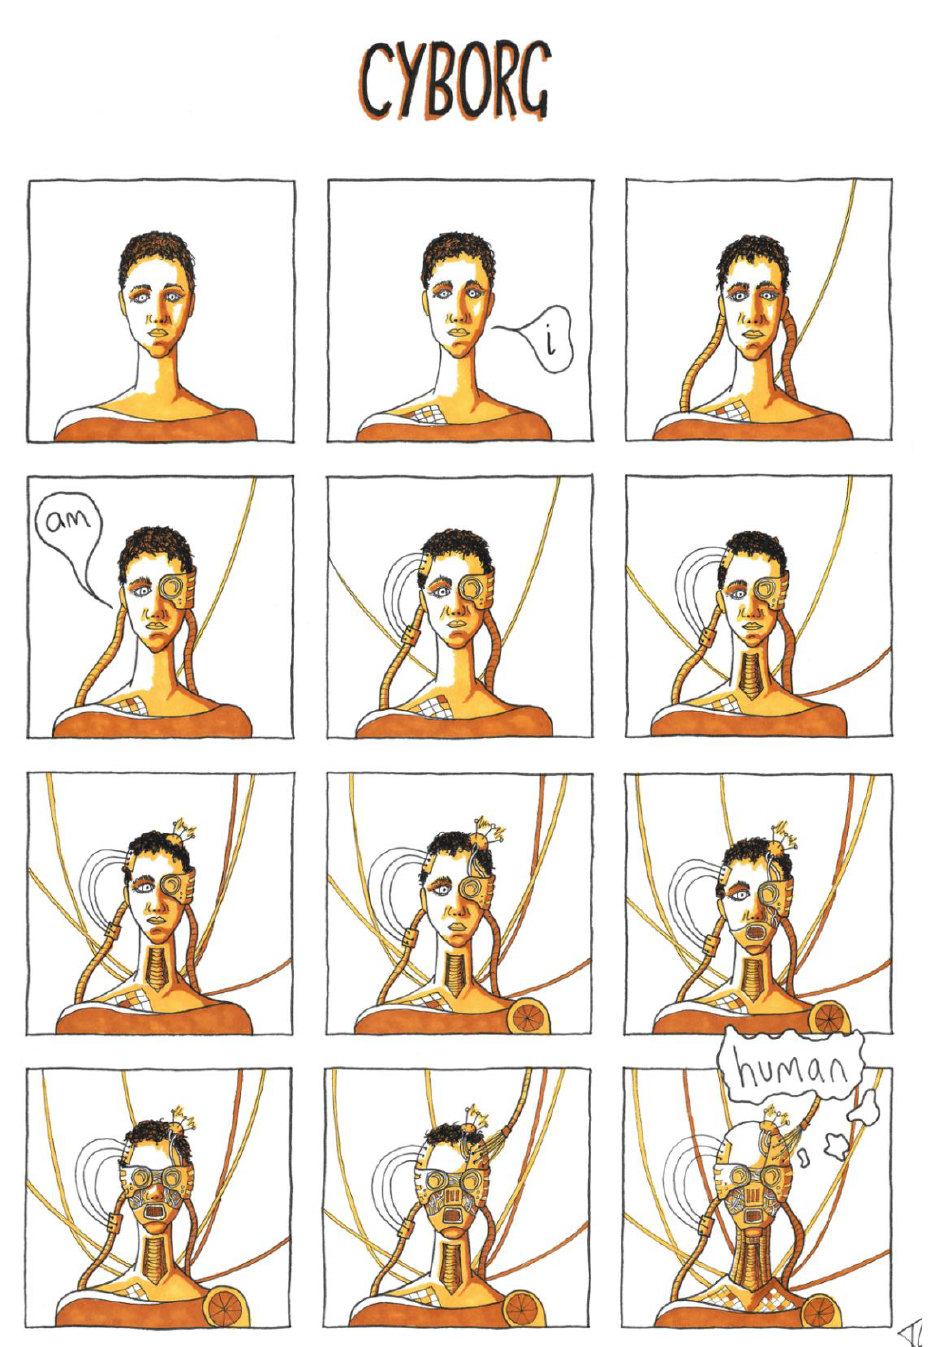
Figure 1. Giddens, Cyborg, 2019. Used with